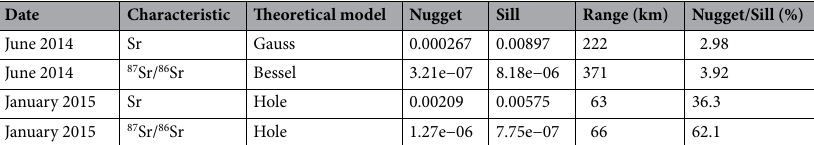
Table 4. Semi-variance function of Sr and its isotopes and the model’s fitting